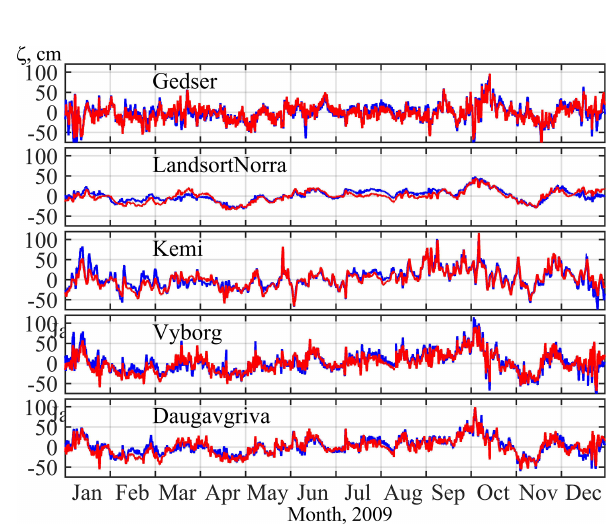
Figure 2. Time series of in situ (blue) and modelled (red) sea level for 2009. The modelled dataset is derived from the basic configura- tion of INMOM (see Sect.